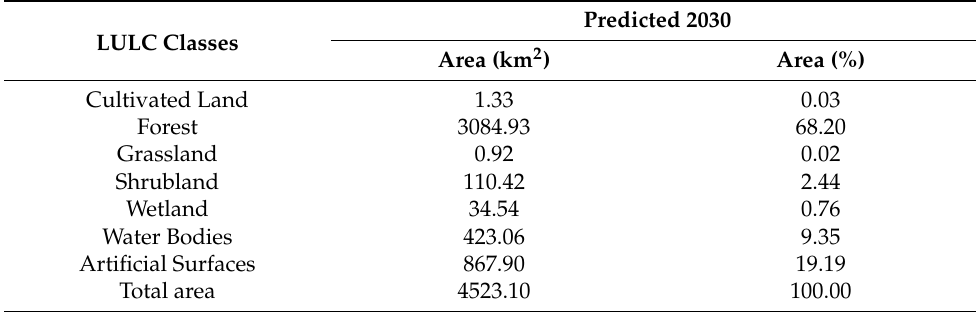
Table 7. Area statistics of predicted LULC in